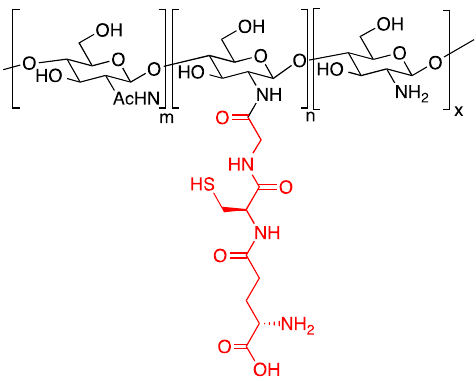
Figure 5. The chitosan-glutathione conjugated hydrogel able to suppress oxidative stress in cardiomiocytes.